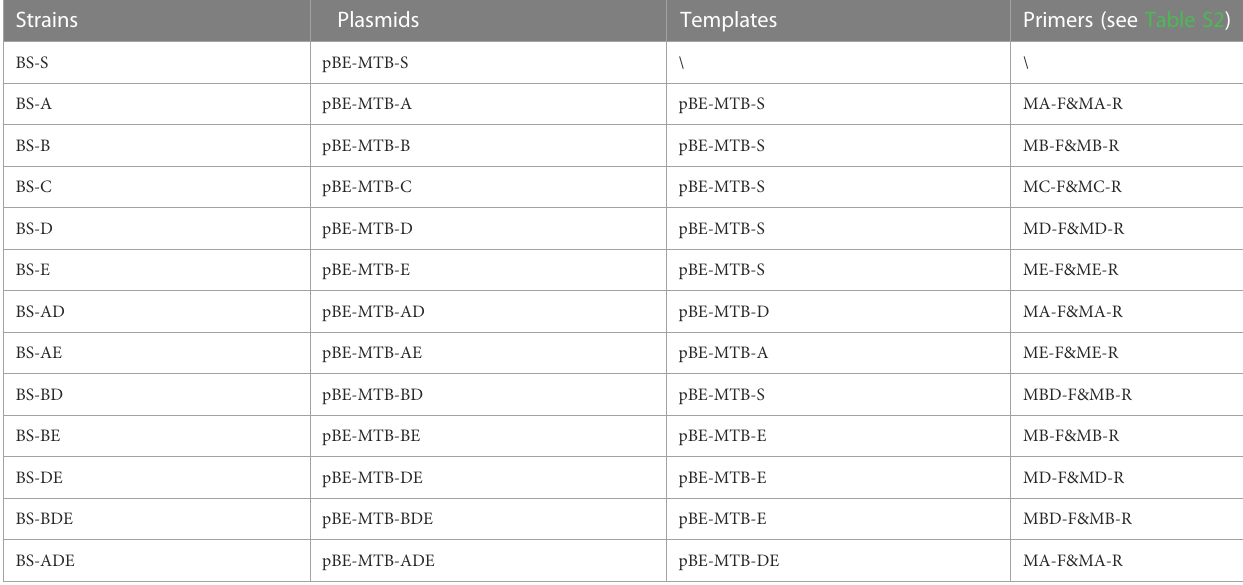
TABLE 1 Mutant strain based on B.